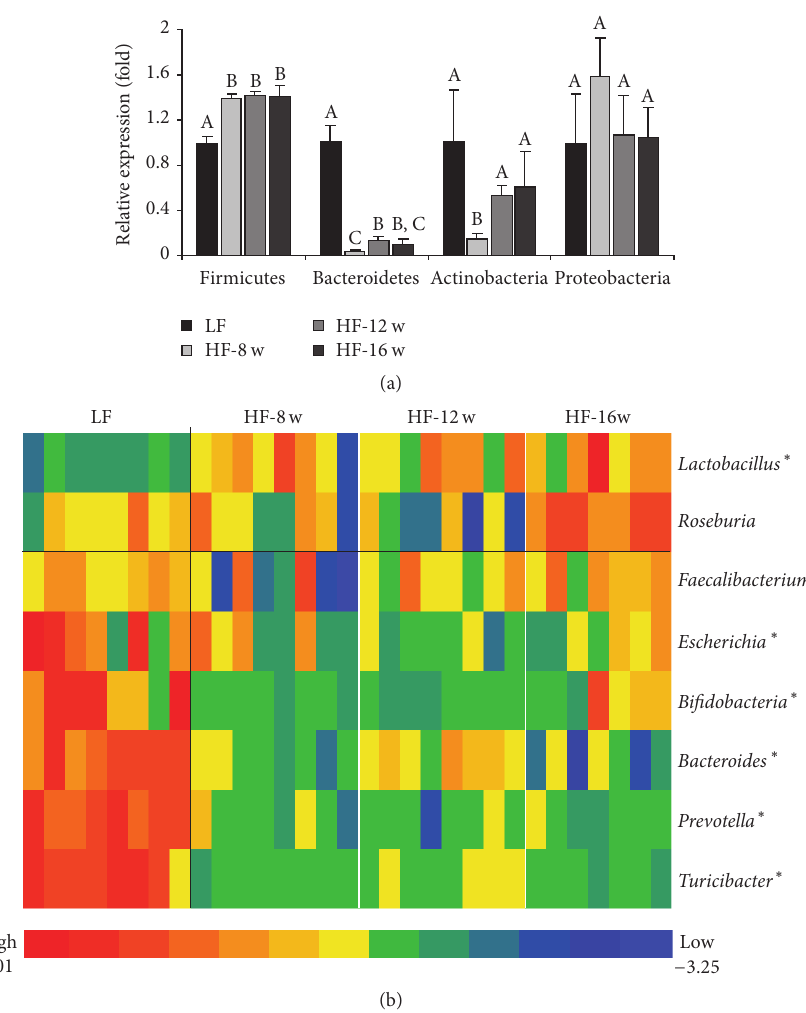
Figure 1: Effect of high fat diet and time course of feeding on the composition of gut microflora. Based on the data of 4 phyla (a) and 8 genera (b) examined, the gut microflora were significantly altered after 8 wk feeding of a high fat diet, and no significantly alterations occurred for further high fat consumption. ∗ means there were significant changes ( 𝑝 < 0.05 ) between HF and LF